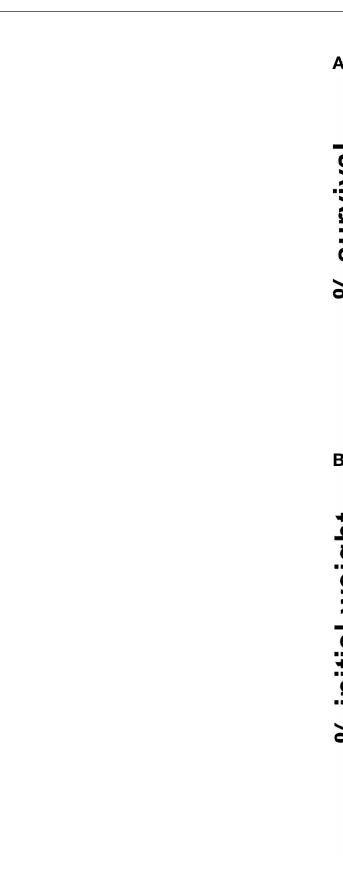
FIGURE 4 | Survival of mice lacking Mincle and Nod2 singly and in combination after infection with Mtb . (A) , percent survival. Log-rank (Mantel-Cox) test p values with Bonferrroni-correction for fi ve comparisons, comparing to WT, equal 0.249, 0.0805 and 0.0080 for Mincle -KO, Nod2 -KO and DKO, respectively; for comparison to DKO, corrected p values equal 0.202 and > 0.99 for Mincle -KO and Nod2 -KO, respectively. (B) , percent weight from 6 days post-infection over time for the indicated genotype (male and female mice combined); median (lines) +/- interquartile range (shading) are shown. Euthanized mice received a weight of 0. Weight in grams is plotted in Figure S4 . Median day 1 pulmonary Mtb load was 31 CFU. N = 12, 8, 12 and 14 for WT, Mincle -KO, Nod2 -KO and DKO,